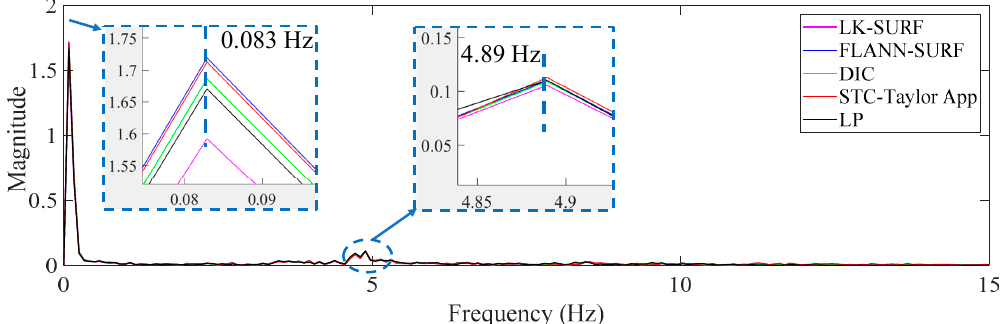
Figure 14. Displacement comparison in the frequency domain of Case 1.